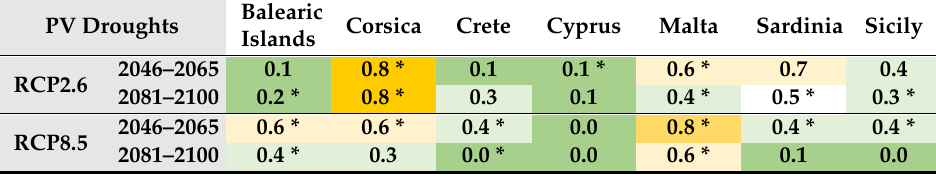
Table 8. Normalized changes (Nc) for PV productivity droughts for each island, scenario and time period. Deep green cells: Nc = 0–0.2; Light green: Nc = 0.3–0.4; White: Nc = 0.5; Light yellow: Nc = 0.6–0.7; Deep yellow: Nc = 0.8–1. Nc and Nu are computed over land. The * indicates the cases in which Nu >